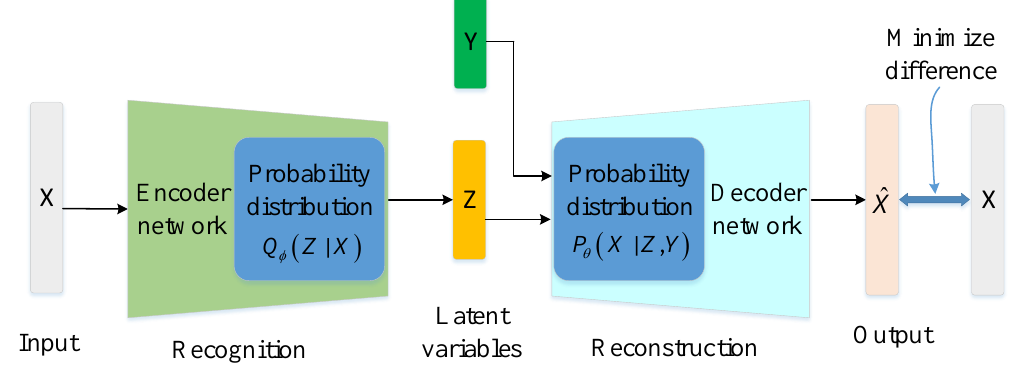
Figure 3. Improved conditional variational AutoEncoder (ICVAE)